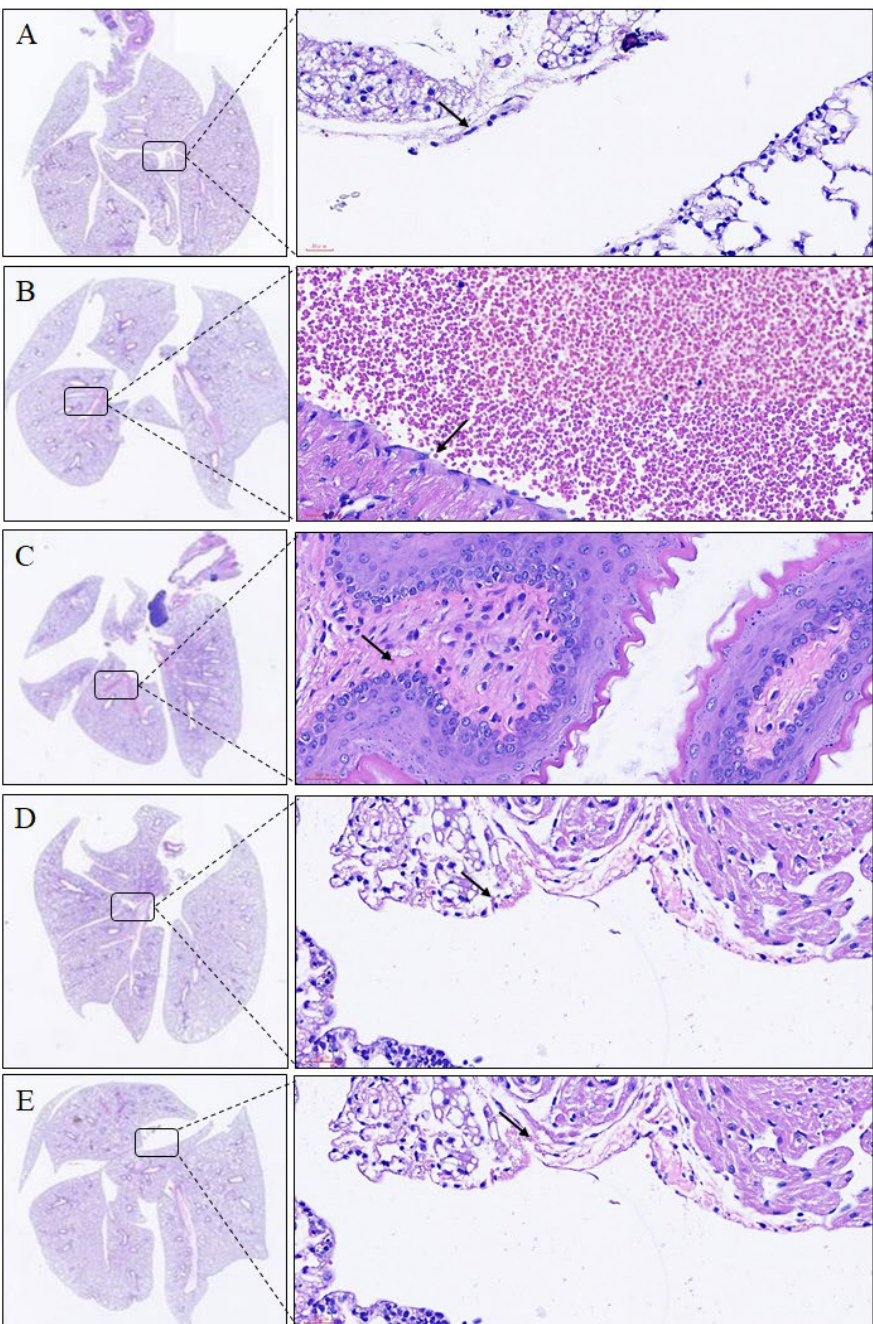
Figure 4. Trachea histological examination results for Der p -induced allergic mice treated with imperatorin. Eosinophil is indicated by black arrow, and hematoxylin–eosin staining results are presented at 400× magnification: ( A ) control group; ( B ) Der p group; ( C ) Der p ± imperatorin 1 mg/kg group; ( D ) Der p ± imperatorin 5 mg/kg group; ( E ) Der p ± imperatorin 10 mg/kg group.